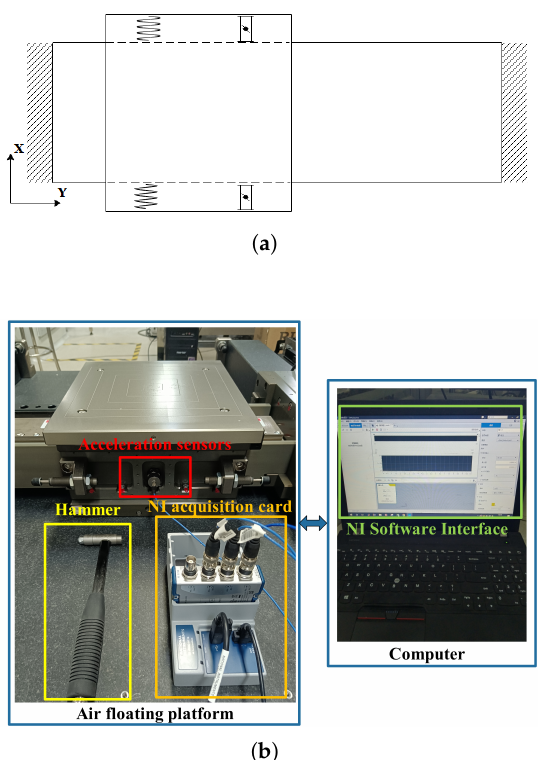
Figure 16. ( a ) Schematic diagram of the experimental platform. ( b ) Physical diagram of the air floating